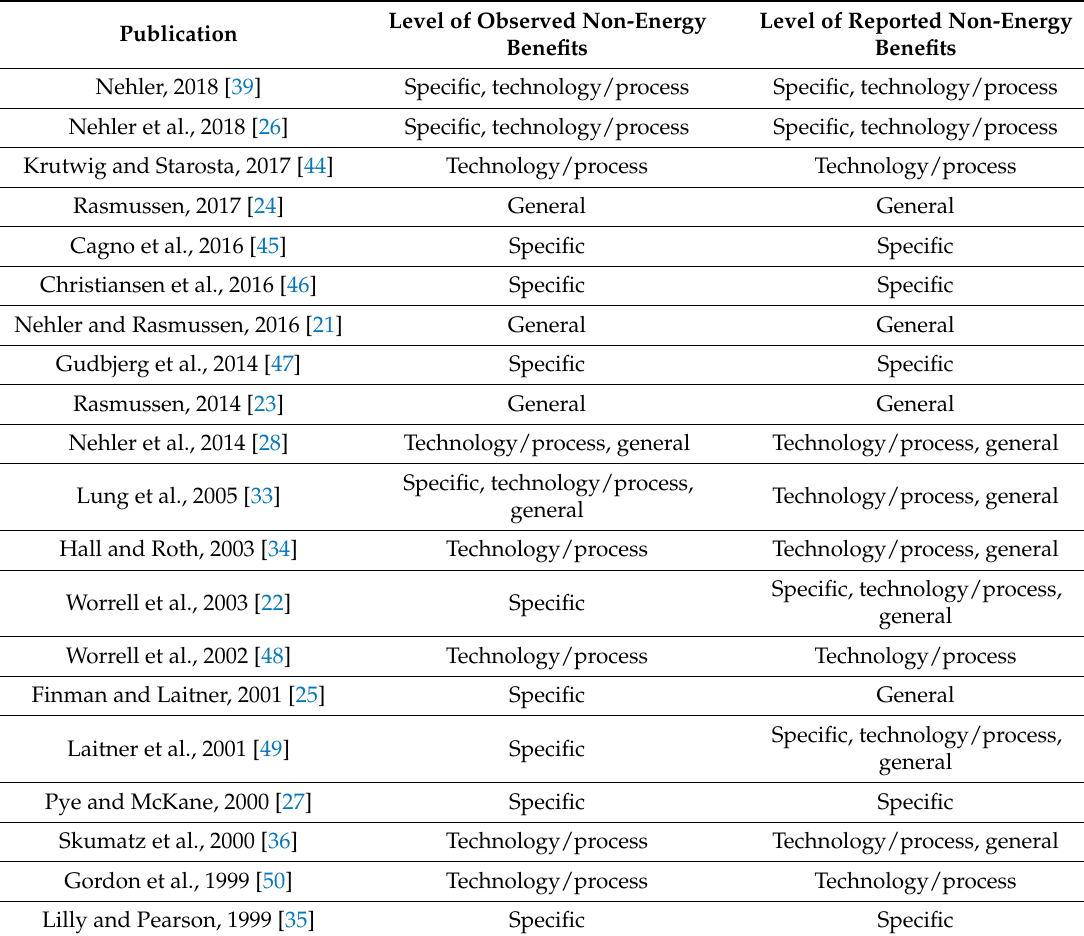
Table 4. Level of observed and reported non-energy benefits in the reviewed publications in the area of non-energy benefits in